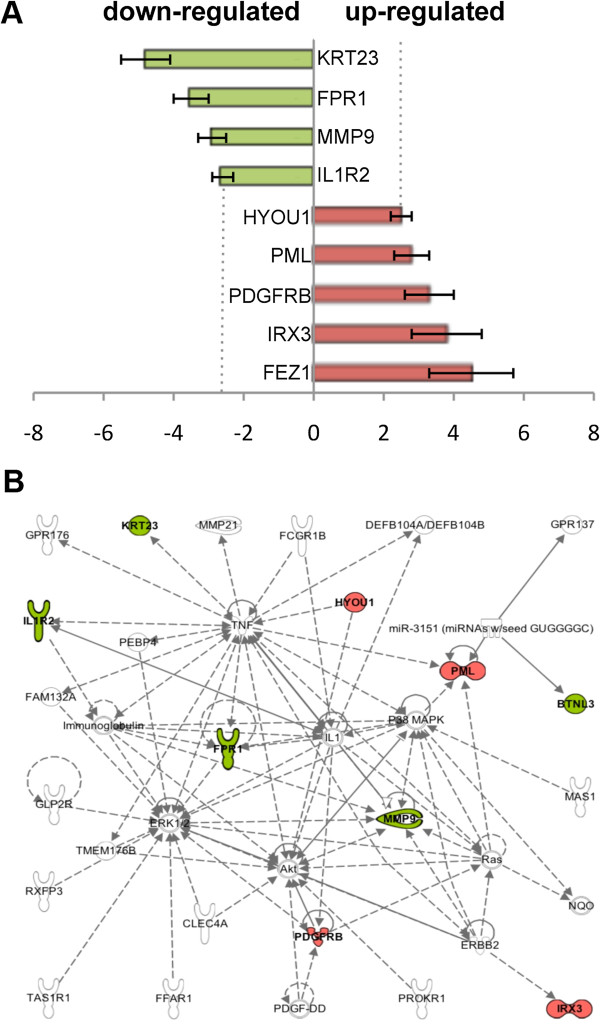
Differential expression of genes depending on BTNL8/BTNL3 genotype. (A) Nine genes could be confirmed by RT-qPCR analysis to be differentially expressed in LCLs homozygous for the BTNL8_BTNL3-del allele. Red, increased mRNA level; green, decreased mRNA level in LCLs homozygous for the CNV. (B) Network of genes formed by Ingenuity Pathway Analysis. Genes depicted in red (increased mRNA level) and green (decreased mRNA level) were confirmed by RT-qPCR analysis to be differentially expressed in LCLs homozygous for the CNV. Genes depicted in white were not found to be deregulated even though they are part of the same network.